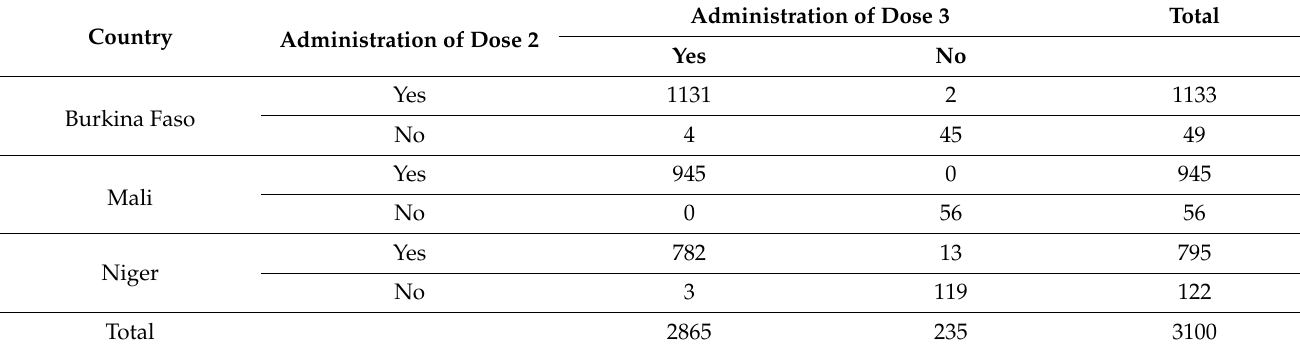
In Burkina Faso, 4.15% (49/1182) of parents/caregivers did not administer the second dose compared to 3.98% (47/1182) for the third dose (X 2 = 0.04, p = 0.083). In Mali, a similar proportion of parents/caregivers did not proceed with the administration of the second and the third doses [5.60% (56/1001)]. In Niger, 13.30% (122/917) and 14.39% (132/917) of parents/caregivers did not administer the second and third doses, respectively (X 2 = 0.46, p = 0.49), (Table 2). Overall, the proportion of non-adherence for the second dose was comparable between Burkina Faso and Mali [4.15% versus 5.6%, risk difference = − 1.45, 95% CI ( − 3.27; 0.37), p = 0.114]. Compared to Niger, these proportions of non-adherence in Burkina and Mali were significantly lower [Burkina Faso vs Niger: 4.15% versus 13.30%, risk difference = − 9.16, 95% CI ( − 11.63; − 6.68), p < 0.001 and Mali vs Niger: 5.6% versus 13.3%, risk difference = − 7.71, 95% CI ( − 10.33; − 5.09), p < 0.001]. Non-adherence of the third dose was also significantly lower in Burkina Faso compared to Niger [3.98% and 14.39%, risk difference = − 10.42, 95% CI ( − 12.95; − 7.89), p < 0.001] and in Mali compared to Niger [5.6% and 14.39%, risk difference = − 8.65, 95% CI ( − 11.31; − 5.98), p <0.001]. Finally, the proportion of non-adherence of the third dose was similar in Burkina Faso and Mali [3.98% versus 5.6%, risk difference = − 1.62, 95%CI ( − 3.43; 0.19), p = 0.0756]. Table 2. Frequencies of non-adherence of doses 2 and 3 in Burkina Faso, Mali and